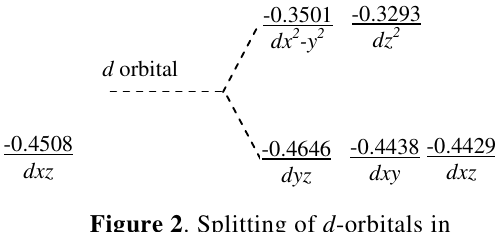
Figure 1. Splitting of d -orbitals in .4NAU. NiCl 2